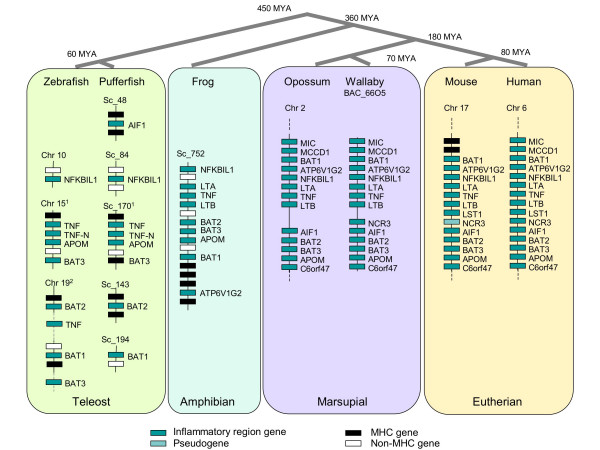
Organisation of the inflammatory region genes across vertebrates. Class III gene orthologues were obtained from the Ensembl genome databases [60] for mouse (Mus musculus) (NCBI m36), opossum (M. domestica) (MonDom4), frog (X. tropicalis) (JGI 4.1), pufferfish (Takifugu rubripes) (FUGU 4.0) and zebrafish (Danio rerio) (Zv 6). Gene organisation was determined for each species based on these genome assemblies as well as from previously published work for opossum [4] zebrafish [8, 61] and frog [3].